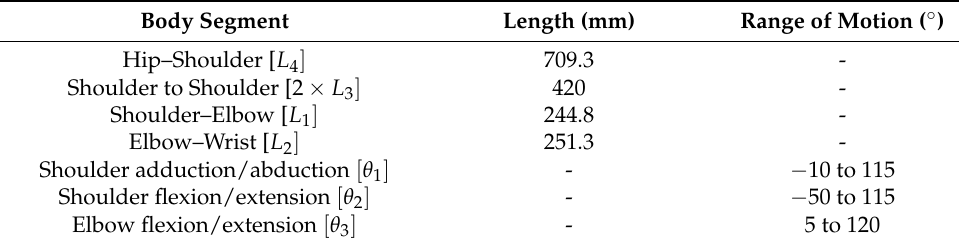
Figure 3. ( a ) Geometric configuration of shoulder flexion/extension and elbow flexion/extension joint angles noted as (cid:2016) (cid:2870) and (cid:2016) (cid:2871) , respectively. ( b ) Geometric configuration of shoulder abduc- tion/adduction joint angle noted as (cid:2016) (cid:2869) .